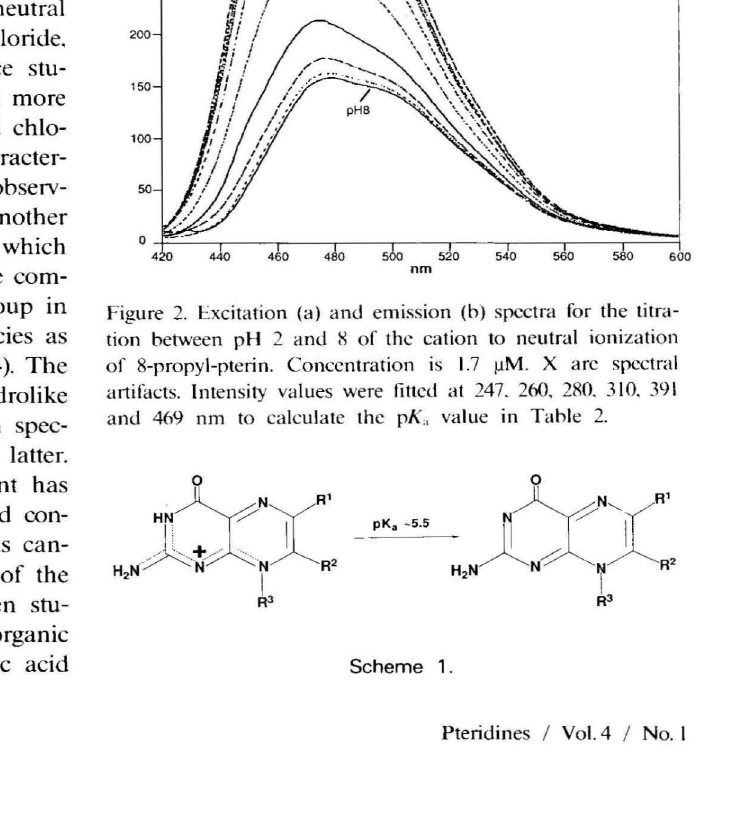
Scheme 1. Pteridines / Vol. 4 I No.